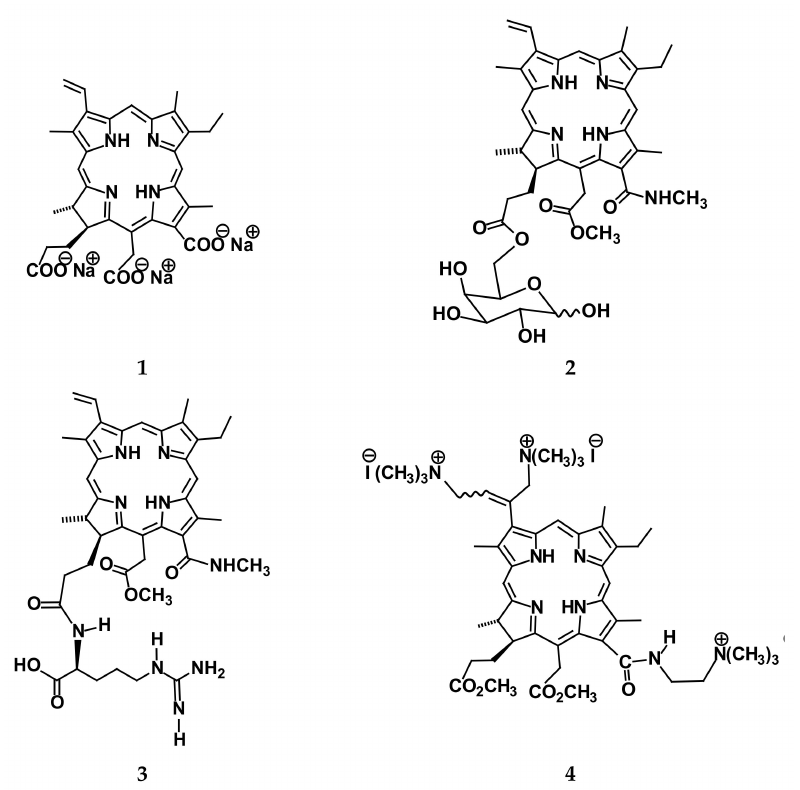
Figure 1. Molecular structures of the PSs studied: 1 —chlorin e 6 trisodium salt (comp. 1 ); 2 —chlorin e 6 13(1)-N-methylamide-15(2)-methyl ester-17(3)-O-6 (cid:48) -galactopyranosyl ester (comp. 2 ); 3 —chlorin e 6 13(1)-N-methylamide-15(2)-methyl ester-17(3)-[N-1 (cid:48) -(1 (cid:48) -carboxy-4 (cid:48) -guanidylbutyl) amide] (comp. 3 ); 4 —chlorin e 6 3(1),3(2)- bis -(N,N,N-trimethylaminomethyl iodide)-13(1)-N (cid:48) - (2-N (cid:48)(cid:48) ,N (cid:48)(cid:48) ,N (cid:48)(cid:48) -trimethyl ammonioethyl iodide) amide 15(2),17(3)-dimethyl ester (comp. 4